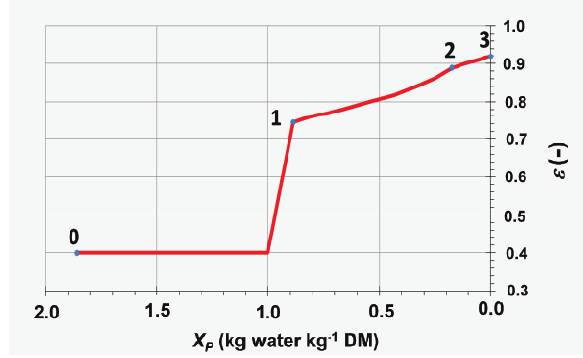
Fig. 9 – Fluid layer porosity e (–) vs. moisture content of the particles X (kg water kg –1 DM) p